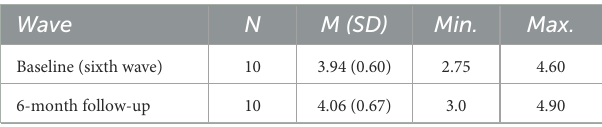
TABLE 4 Baseline and 6-month follow-up NoMAD